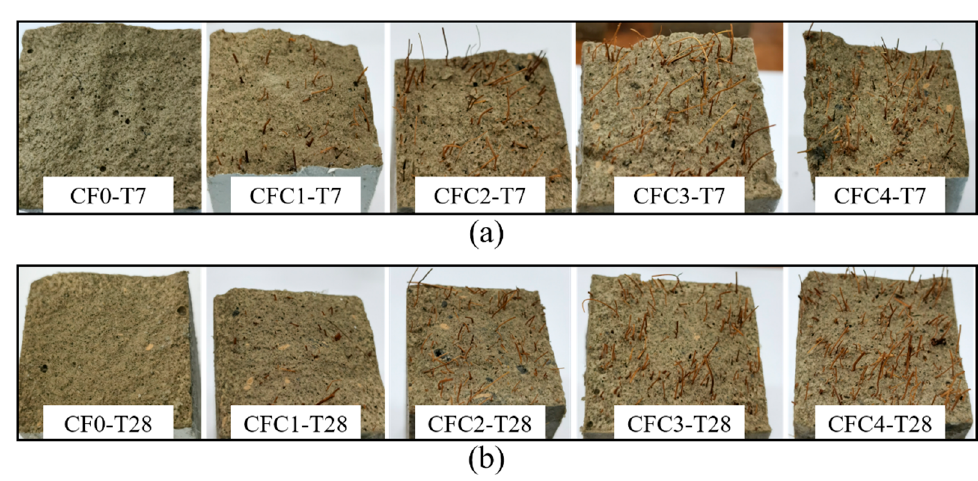
Figure 7. Fracture surface: ( a ) group T7; ( b ) group T28.